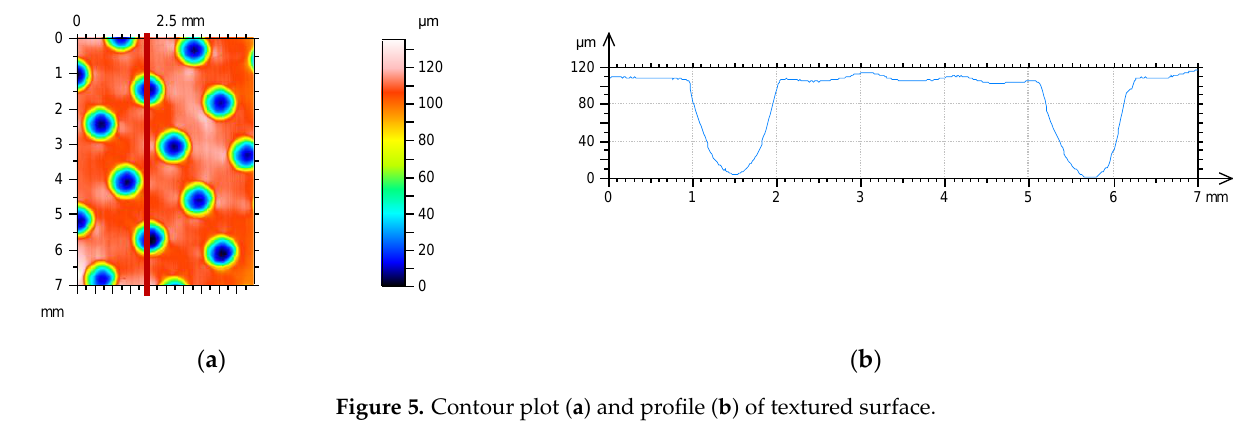
Figure 5. Contour plot ( a ) and profile ( b ) of textured surface.